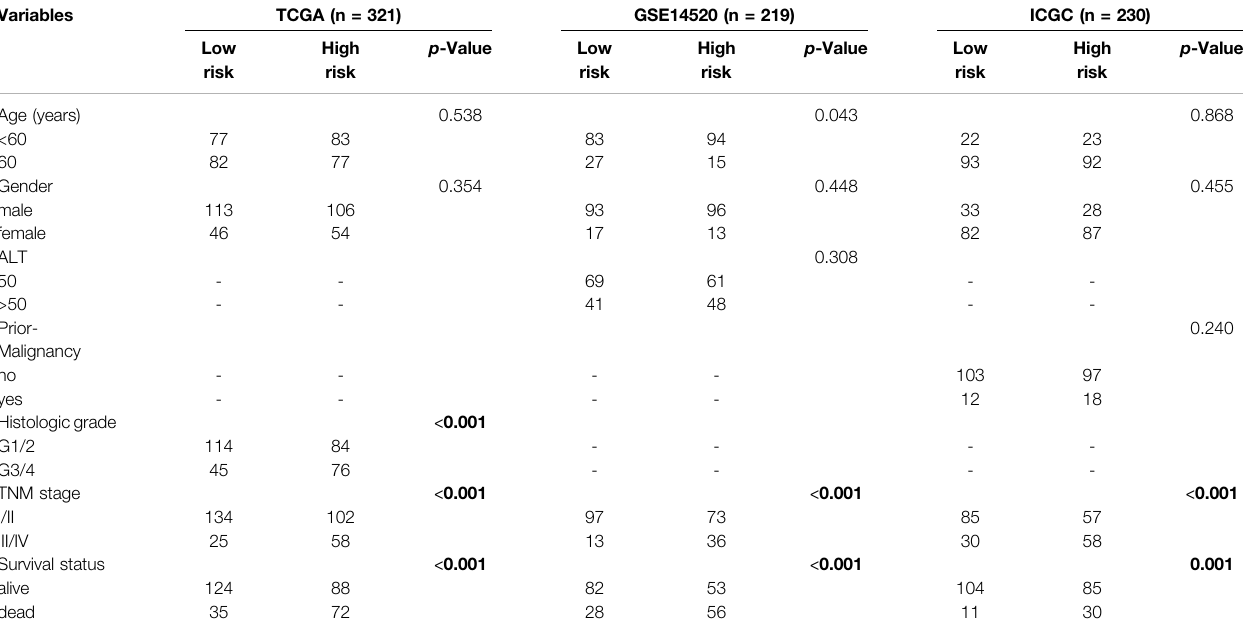
EMT,Epithelial-mesenchymaltransition;HCC,hepatocellularcarcinoma;ALT,alaninetransaminase;TNM,tumornodemetastases;TCGA,thecancergenomeatlas;ICGC,international cancer genome consortium. Bold value represent p < 0.05.